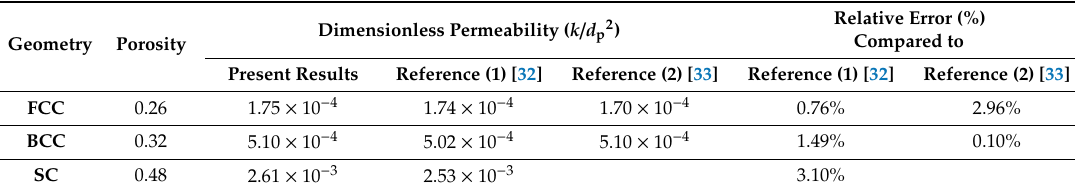
Table 2. Comparison of the results for dimensionless permeability with prior results. The reported error is the relative absolute error compared to references.